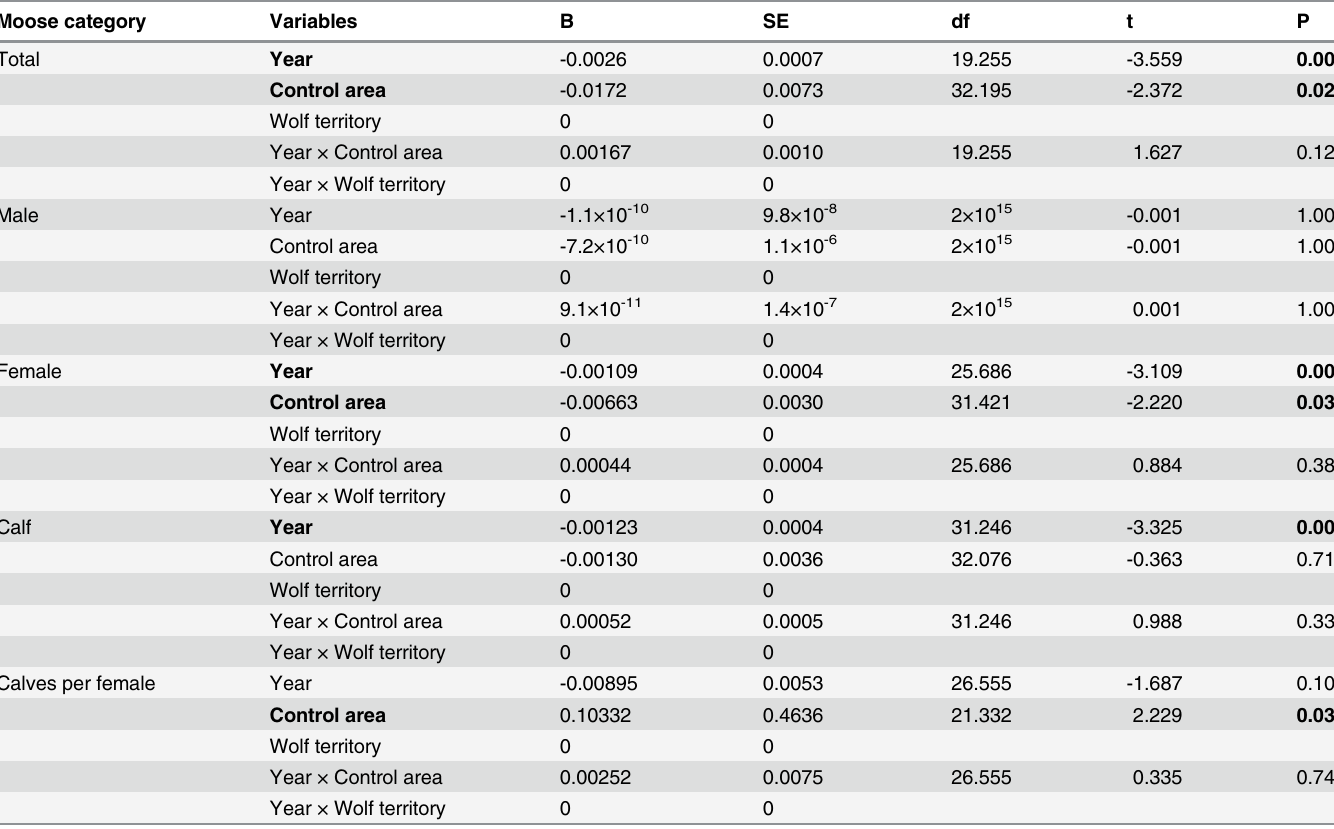
Table 6. Parameter values (B) of the main effect of year (ten-year periods) and type of area (wolf territories and control areas), as well as their inter- action, on the number of moose observed by hunters during the first week of the harvest (total number of moose, females, calves, and calves per female).